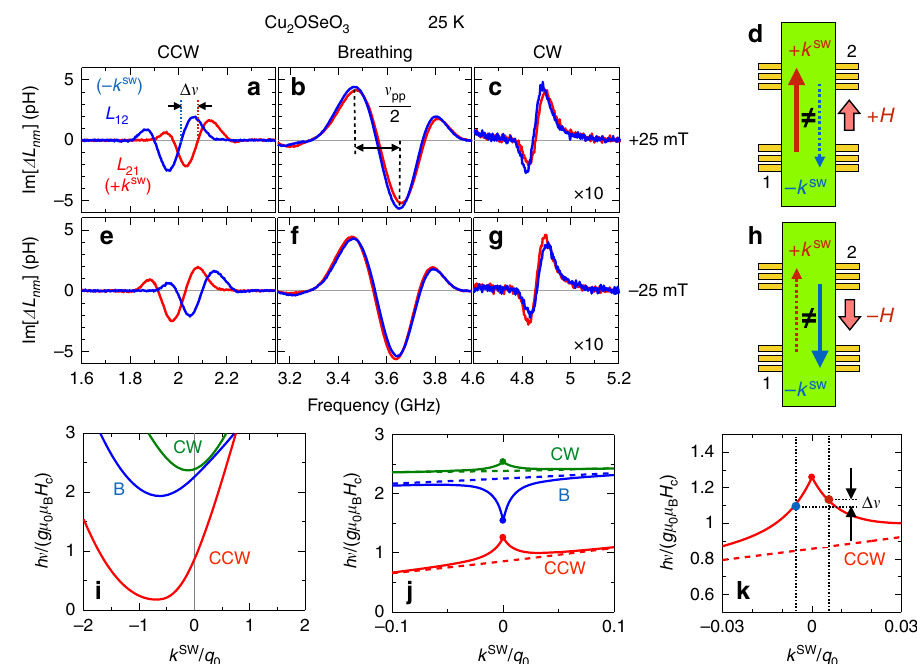
Fig. 2 Propagation character of spin excitations on skyrmion strings. a – c The spectra of mutual inductance Δ L 21 and Δ L 12 , which represent the propagation character of spin excitation with the wave vector + k SW and − k SW , respectively. The data were measured in the SkX state under the con fi guration shown in d at 25 K with μ 0 H = + 25 mT. a , b , and c represent the CCW, B, and CW modes, respectively. e – h The corresponding data measured with μ 0 H = − 25 mT. i – k Dispersion relation for various spin excitations on skyrmion strings, theoretically calculated for the k SW ∥ H con fi guration with H = 0.4 H c . Here, h , g , μ 0 , μ B , H c , and q 0 are Planck constant, g -factor, vacuum magnetic permeability, Bohr magneton, critical fi eld value to induce FM state, and magnetic modulation pitch, respectively. In j and k , the solid and dashed lines represent the dispersion relation for a fi nite sample in the magnetostatic limit and an in fi nitely extended sample in the bulk limit,